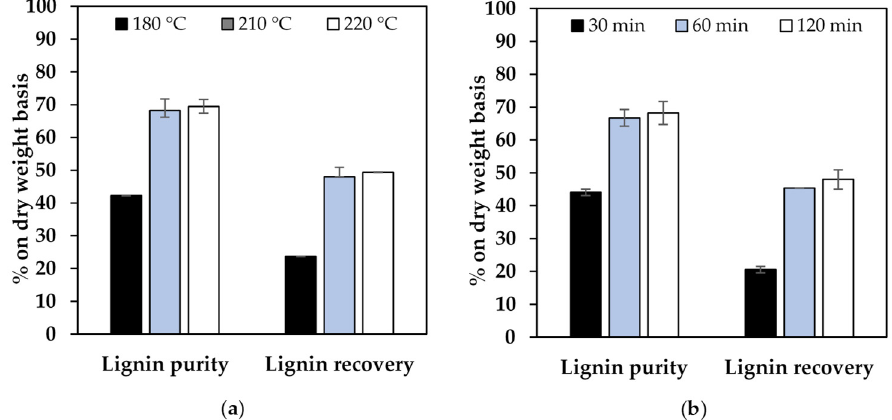
Figure 2. E ff ect of ( a ) temperature (for 120 min and using solid-to-liquid (S / L) ratio of 1:20) and ( b ) retention time (at temperature of 210 ◦ C and S / L ratio of 1:20) on lignin purity ( p -value = 0.001 and p -value = 0.001, respectively) and recovery ( p -value = 0 and p -value = 0, respectively). Error bars represent ± 2 × the standard deviation.